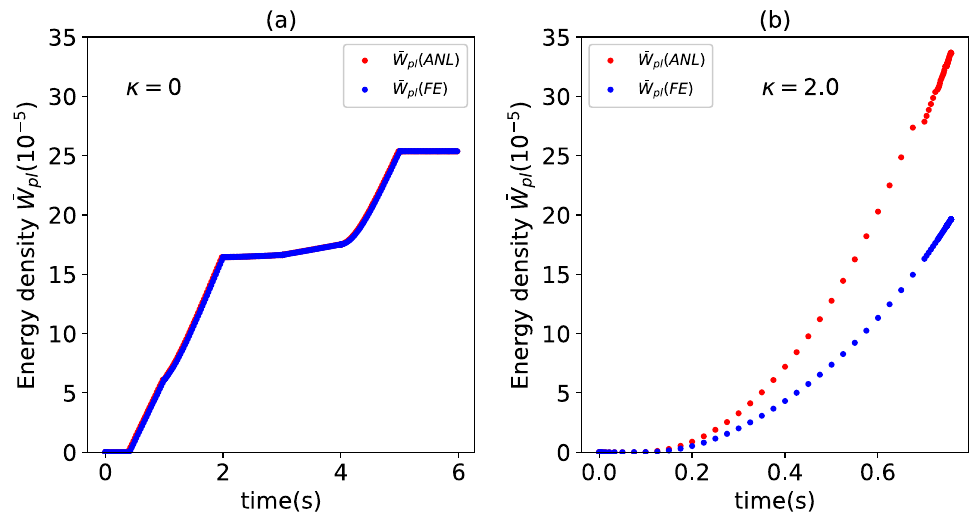
Figure 3. Comparison of the time histories of the density of plastically dissipated energy during selected random multiaxial loading cases, as calculated analytically from Eq. (23) (label ANL ) or obtained from the FE simulations (label FE ). The comparison is made for a homogeneous volume element (( a ), κ = 0 ) and for a heterogeneous material with spatially varying Young’s modulus (κ = 2 ) and uniform plastic properties ( b